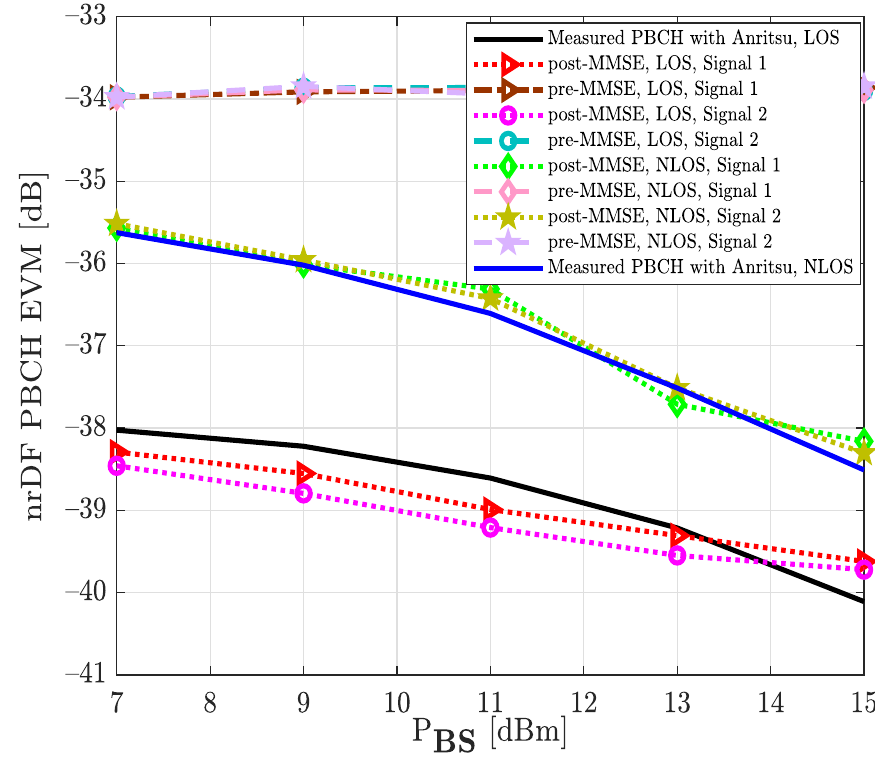
Figure 12. Median EVM at physical broadcast channel for two modulation schemes, LOS and NLOS environment, and equalization step under real